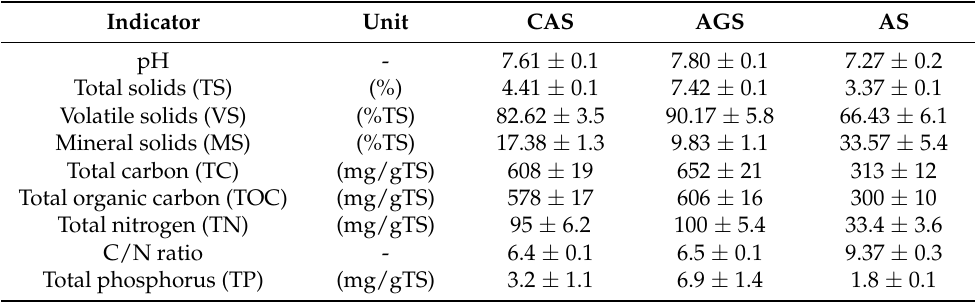
Table 1. Characteristics of AGS and AS inoculum used in the experiment.